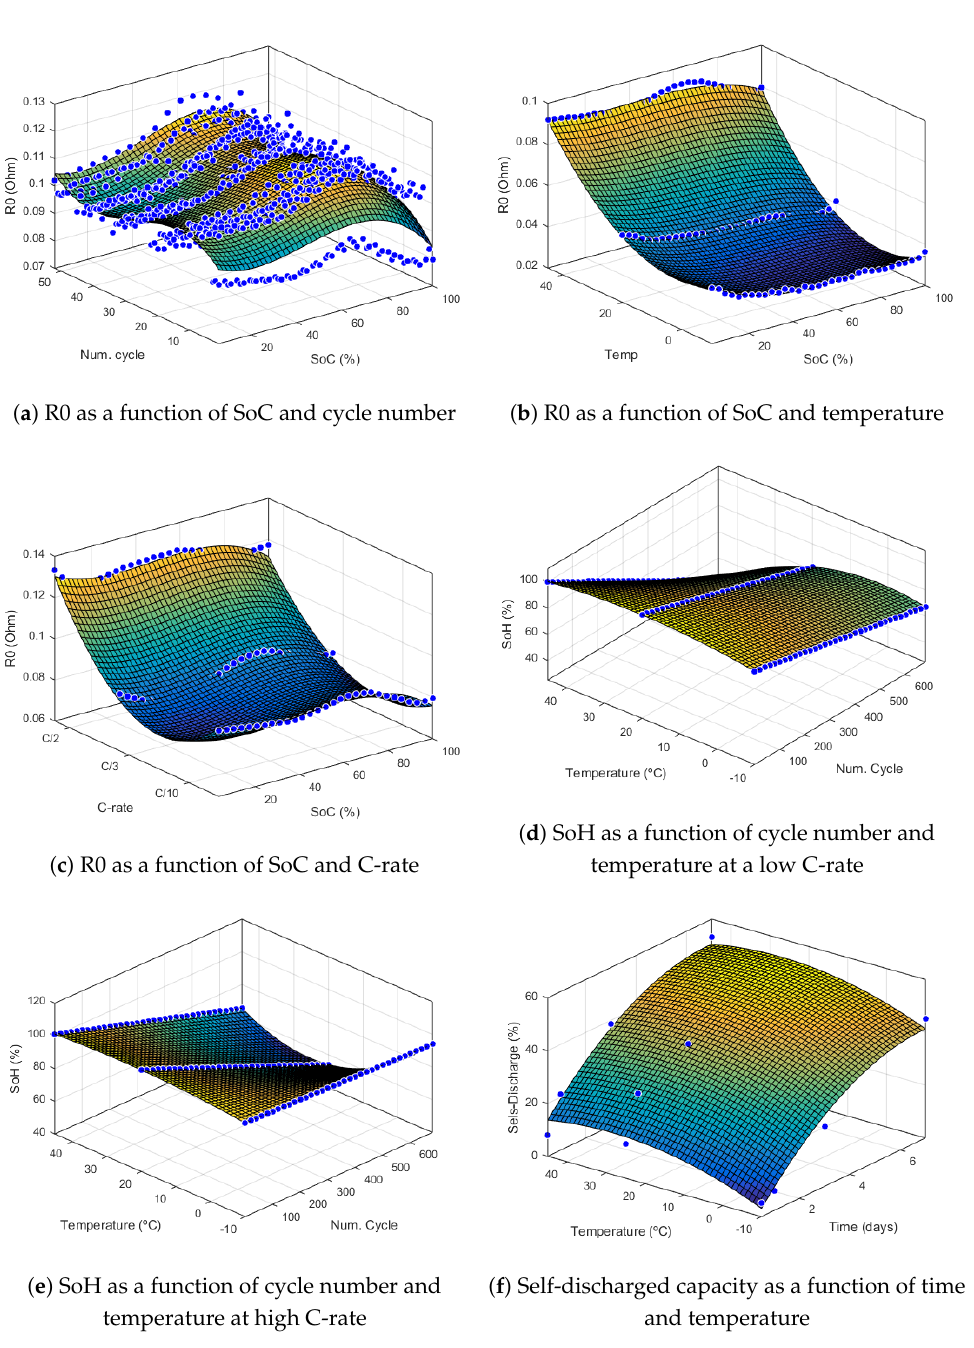
Figure 7. Surface representing the R0-parameter as a function of ( a ) SoC and cycle number, ( b ) SoC and temperature, ( c ) SoC and C-rate, the blue dots are the real values and the surface the estimation obtained. SoH as a function of cycle number and temperature at ( d ) low C-rate and ( e ) high C-rate, the blue dots correspond to the linearized values, ( f ) percentage of self discharged capacity as a function of time and